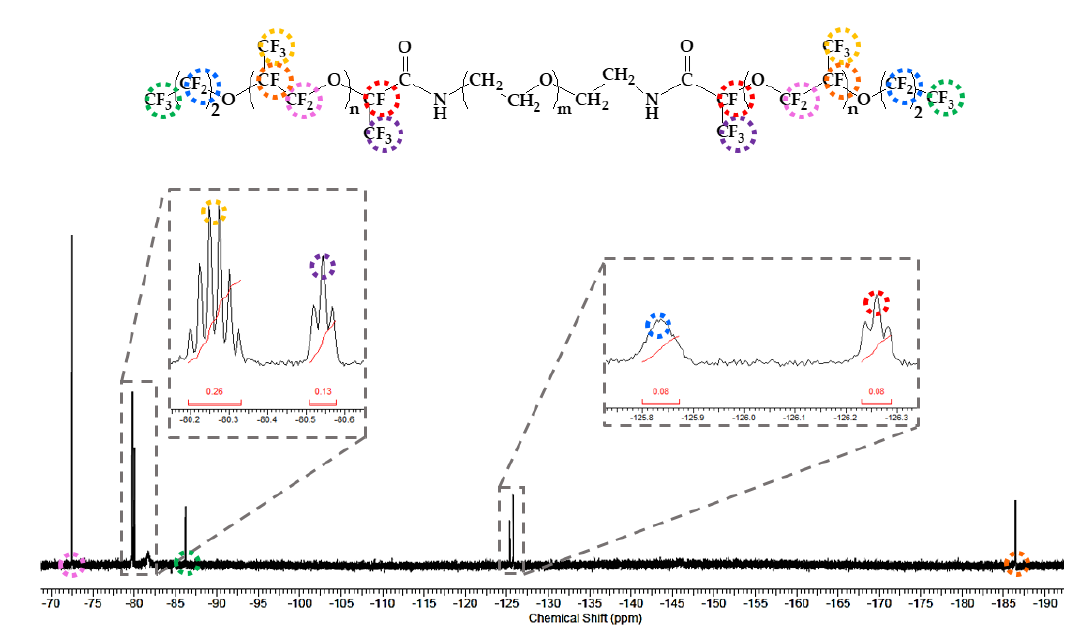
Figure 4. 19 F-NMR spectrum of synthesized PFPE–PEG–PFPE surfactant for structural analysis.